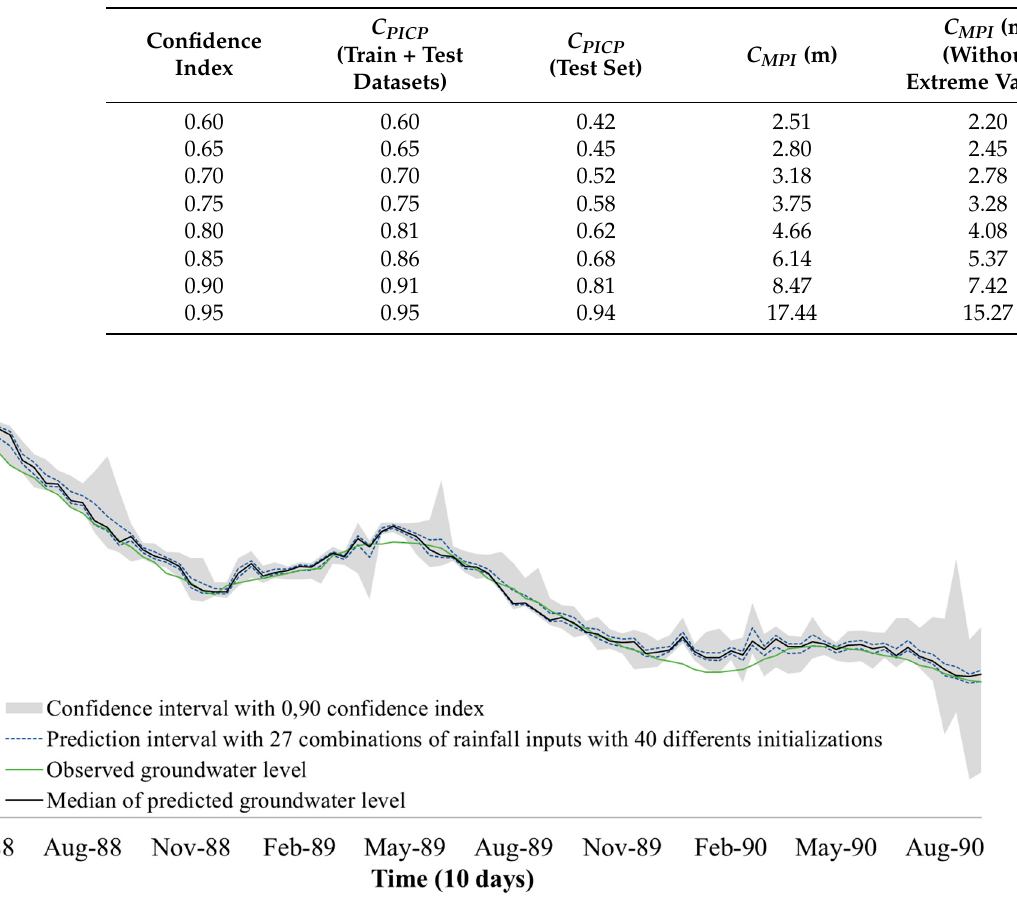
Table 11. Evolution of PICP and MPI scores following confidence index.